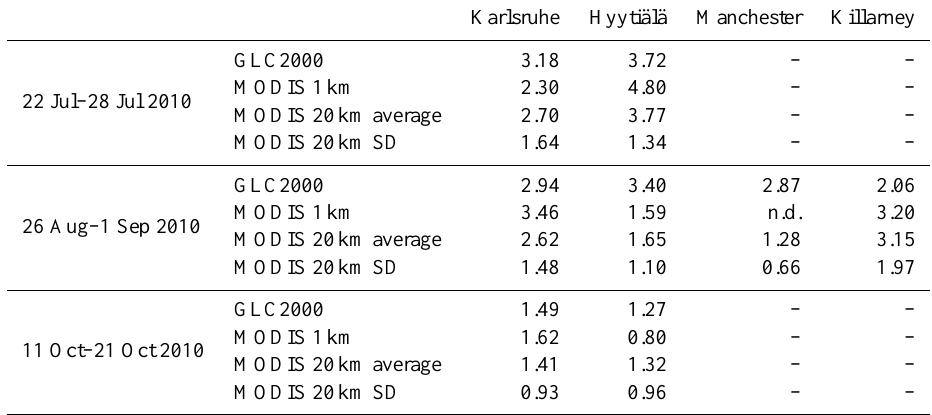
Table 4. Leaf area index (m 2 m − 2 ) from the climatological GLC2000 data set as used in the simulations compared to the nearest neighbor pixel of the 8-day, 1km resolution MODIS LAI and to an average of the 1km resolution MODIS LAI over a 20km × 20km area centered on the station grid point. In addition, the standard deviation within that 20km × 20km area is given. For the Manchester nearest neighbor 1km grid point, no data are available for the given time period